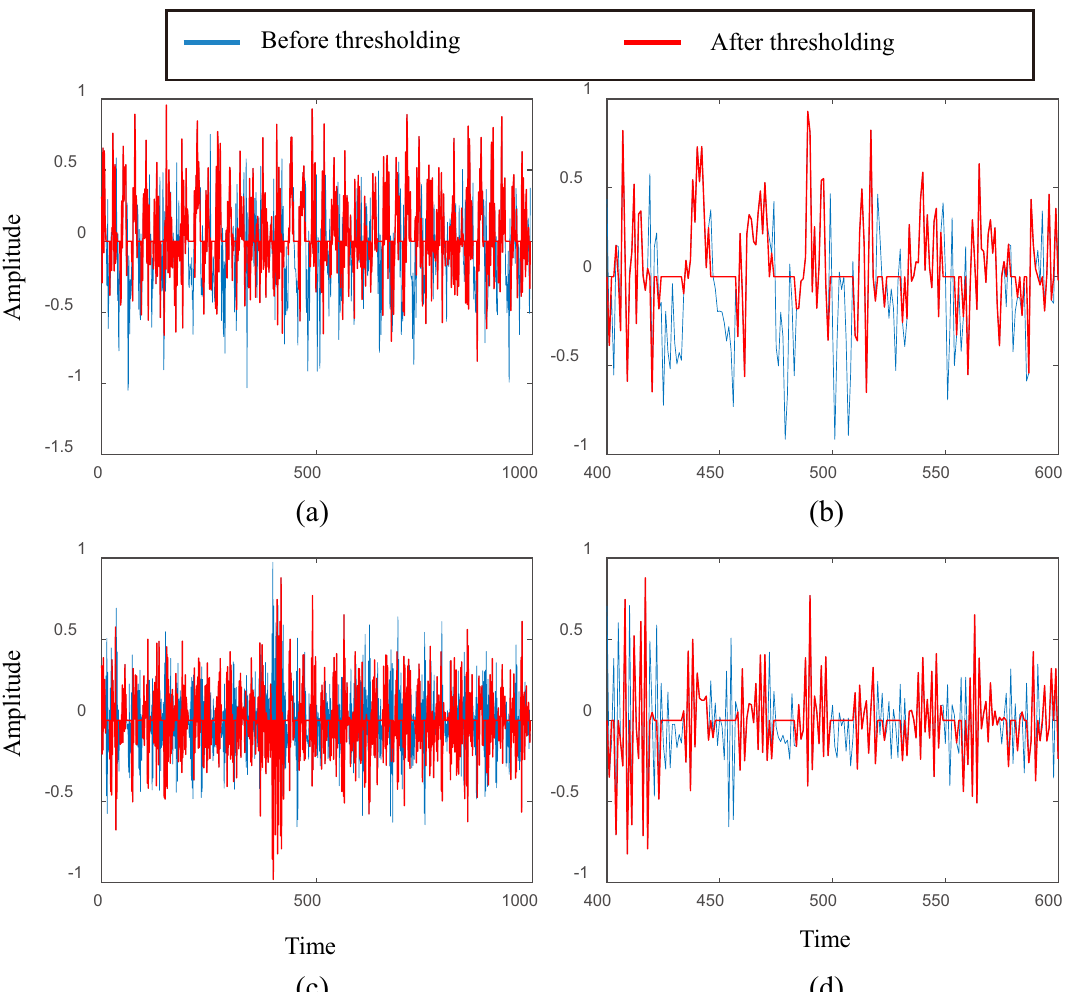
Figure 11 Comparison of features before thresholding and after thresholding: a , b features of the first channel; c , d features of the last channel